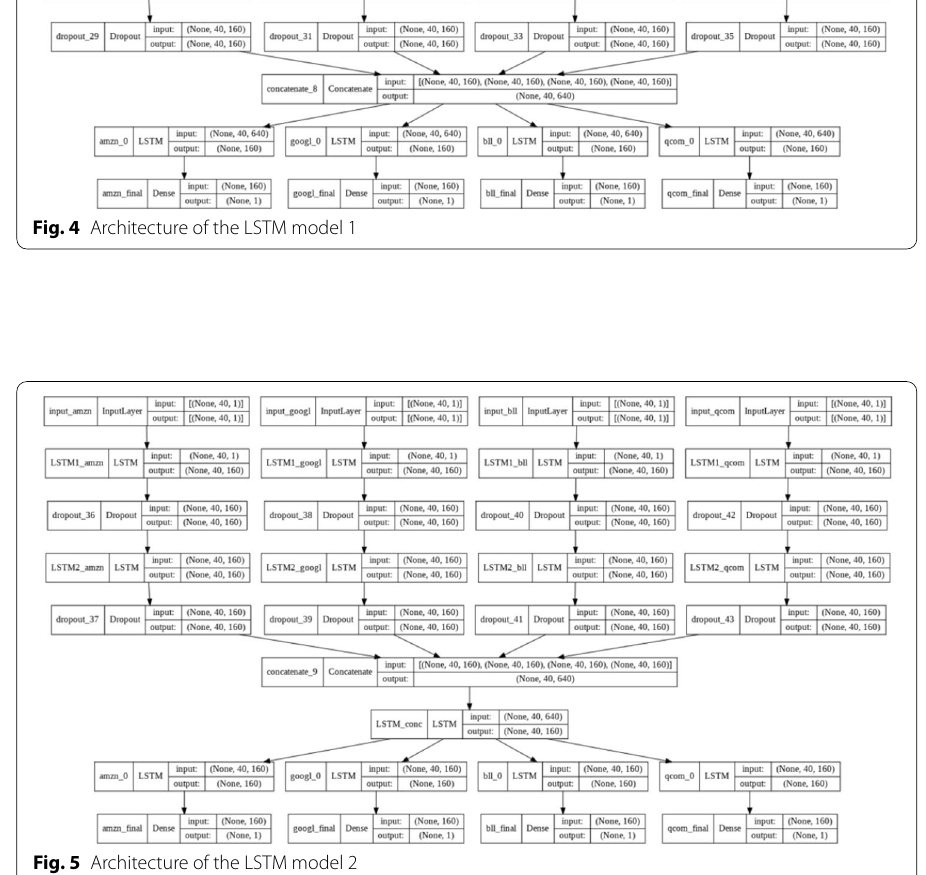
Fig. 5 Architecture of the LSTM model